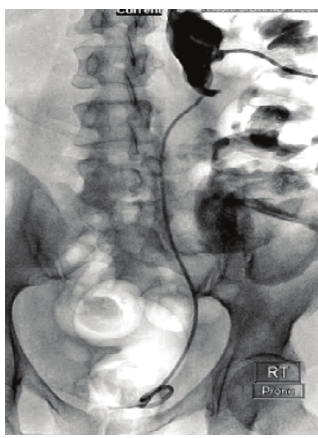
Figure 3: Percutaneous nephrogram illustrating placement of an indwelling 8 Fr double-J ureteral